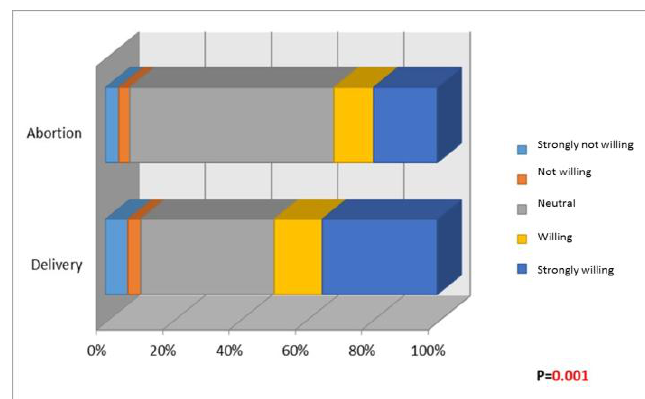
Figure 1: Distribution of patient attitude toward immediate post- partum/abortion contraception according to pregnancy